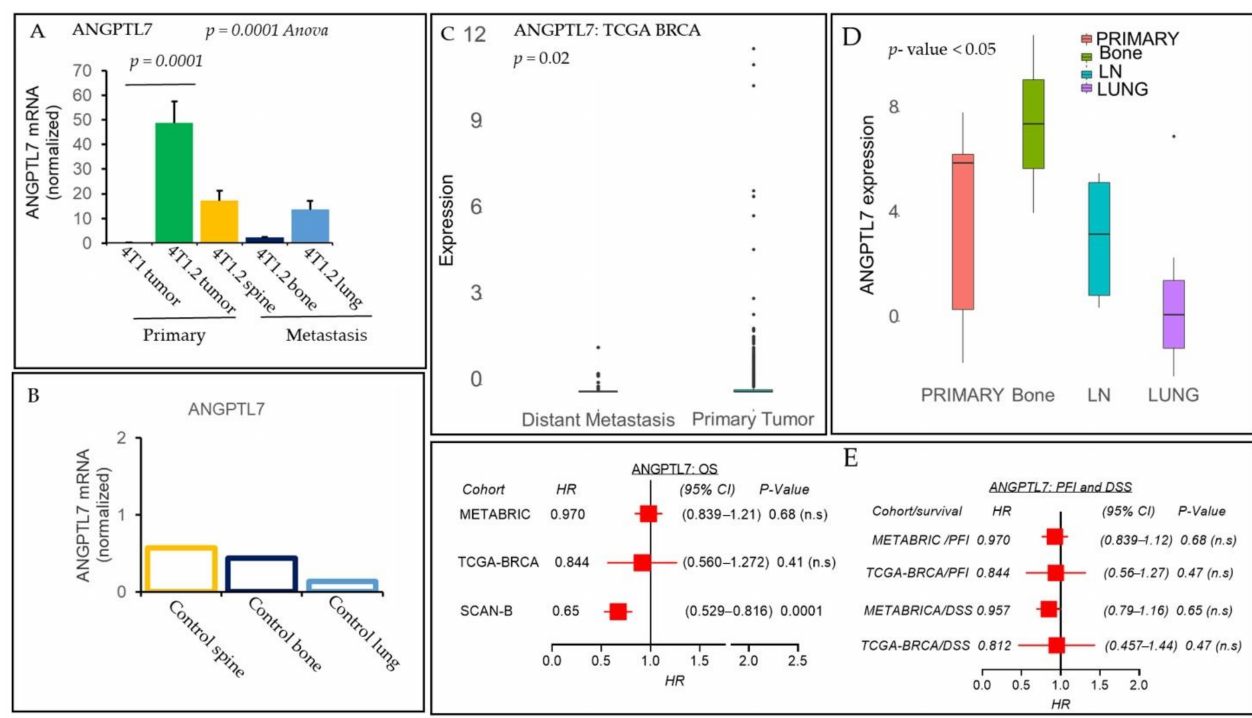
Figure 2. ANGPTL7 is downregulated at the metastatic sites vs. primary tumor and positively impacts breast cancer patients’ survival. ( A ) ANGPTL7 mRNA levels, determined by qPCR analysis, were compared between primary tumors of 4T1 vs. 4T1.2 cells ( n = 3/group). Metastatic lesions of 4T1.2 cells at distant sites such as the spine, bone, and the lung, were used for ANGPTL7 mRNA levels using qPCR analysis ( n = 3). ( B ) ANGPTL7 expression levels were also estimated in the control mice ( n = 3) tissues of the spine, bone, and lung. ANGPTL7 mRNA levels were normalized with GAPDH. All the qPCR experiments were repeated at least twice to obtain consistent results. Data are mean ± SEM, one-way ANOVA p = 0.0001, Tukey’s post hoc test, p < 0.05, n = 3. ( C ) A boxplot shows a high expression score of the ANGPTL7 gene in breast cancer patients of TCGA-BRCA cohort with primary tumors ( n = 979) vs. patients with metastases ( n = 64). The mean bar value for distant metastasis is − 0.16641875, and the primary tumor is − 0.07244. Student’s t -test, p = 0.05. ( D ) Boxplots show a high ANGPTL7 expression score of primary tumors vs. metastasis to bone, LN (lymph node), or the lung in GSE110590 cohort of 16 patients [25], boxplots analyses, Kruskal–Wallis test (non-parametric method), p < 0.05; Tukey’s t -test with medians and inter-quartile ranges, p < 0.05, as a significant difference. ( E ) Patients with a high ANGPTL7 expression score and association of survival in three breast cancer cohorts. Overall survival (OS) in METABRIC, TCGA-BRCA, and SCAN-B cohorts (left) or progression-free survival (PFI) and disease-specific (DSS) survival (right) in METABRIC and TCGA-BRCA cohorts along with hazard ratios (HR) and their 95% confidence intervals (CI) and p -values are shown. Note: Only SCAN-B OS data for a high expression score of ANGPTL7 is significant (HR = 0.65, p =